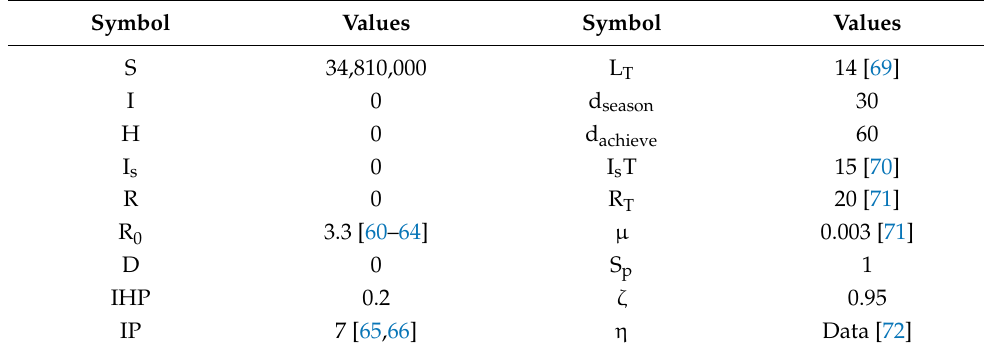
Table 3. Parameter settings for